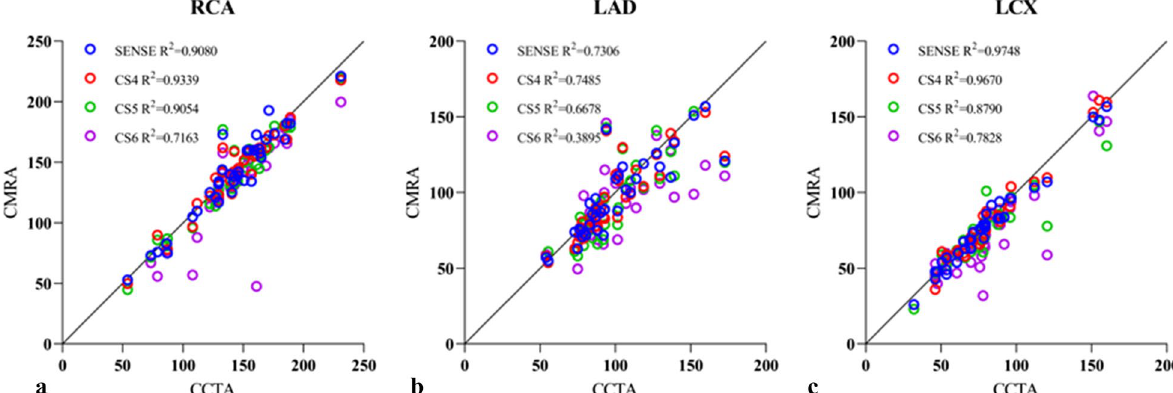
Fig. 5 Scatter plots for vessel measurements using CCTA and NCMRA with four acceleration factors and three arteries. a Right coronary artery, b left anterior descending artery, and c left circumflex artery